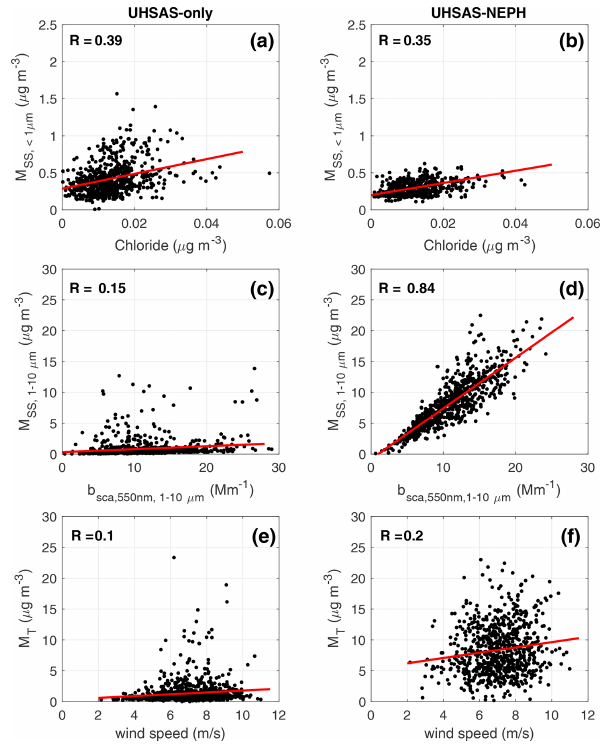
Figure 11. Correlations of submicron sea spray mass ( M SS ,< 1µm ; µgm − 3 ) with ACSM chloride (a, b) , supermicron sea spray mass ( M SS , 1 − 10µm ; µgm − 3 ) with measured supermicron scattering at 550nm (c, d) , and total sea spray mode mass ( M T , µgm − 3 ) with wind speed (e, f) for the UHSAS-only (left) and UHSAS-NEPH (right) methods. Linear regressions are symbolized by red lines and correlation coefficients are provided inside the